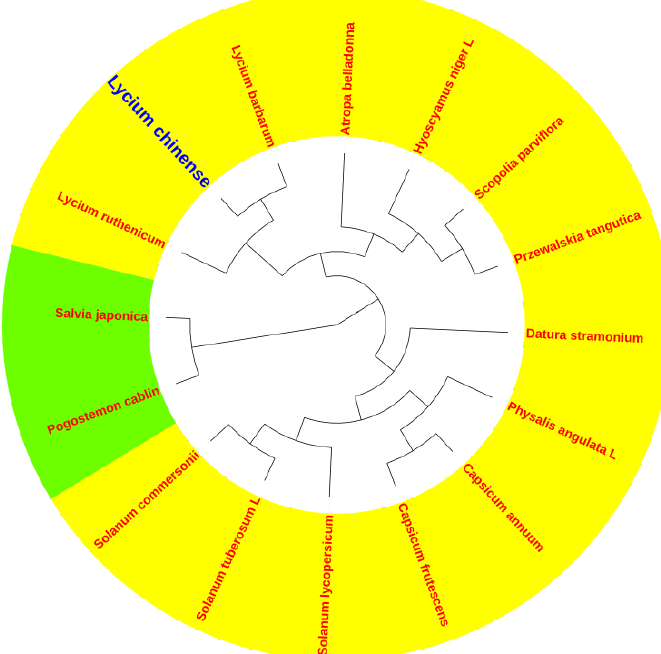
Figure 7. Phylogenetic relationships among 16 species inferred from Bayesian evolutionary analysis by sample tree (BEAST) analyses of complete chloroplast genome sequences, excluding IRa regions. The position of L. chinense is indicated in blue font. Salvia japonica Thunb and Pogostemon cablin (Blanco) Bent were used as outgroups.